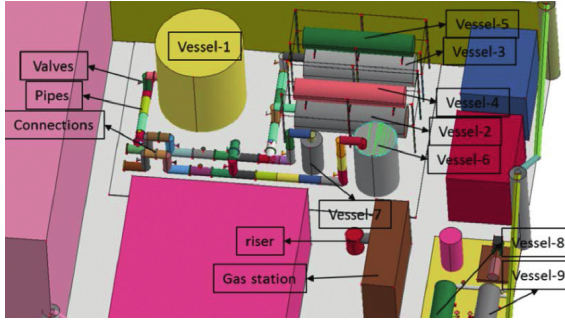
Figure 5: Possible equipment